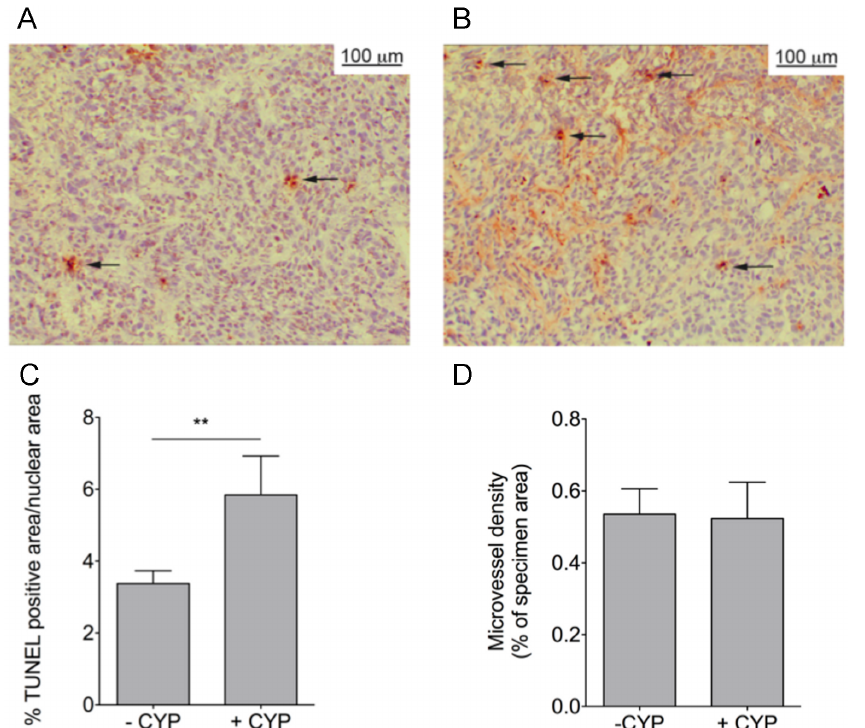
Figure 7. Determination of apoptosis (A–C) and microvessel density (D) in tumors of NMRI nude mice: effects of cyclophosphamide (CYP) treatment. Untreated (–CYP) and treated tumors ( + CYP) were excised from tumor-bearing mice, frozen and sectioned. Sections were stained with TUNEL-assay and hematoxylin. % TUNEL-positive nuclei was determined as a measure of apoptosis (A–C). Panel A shows TUNEL-staining of a section of an untreated tumor and panel B of a CYP-treated tumor. Sections were stained with the endothelial specific antibody anti-CD31 and hematoxylin. Microvessel density was determined as % of tumor area that is CD31-positive (D). **p , 0.01.